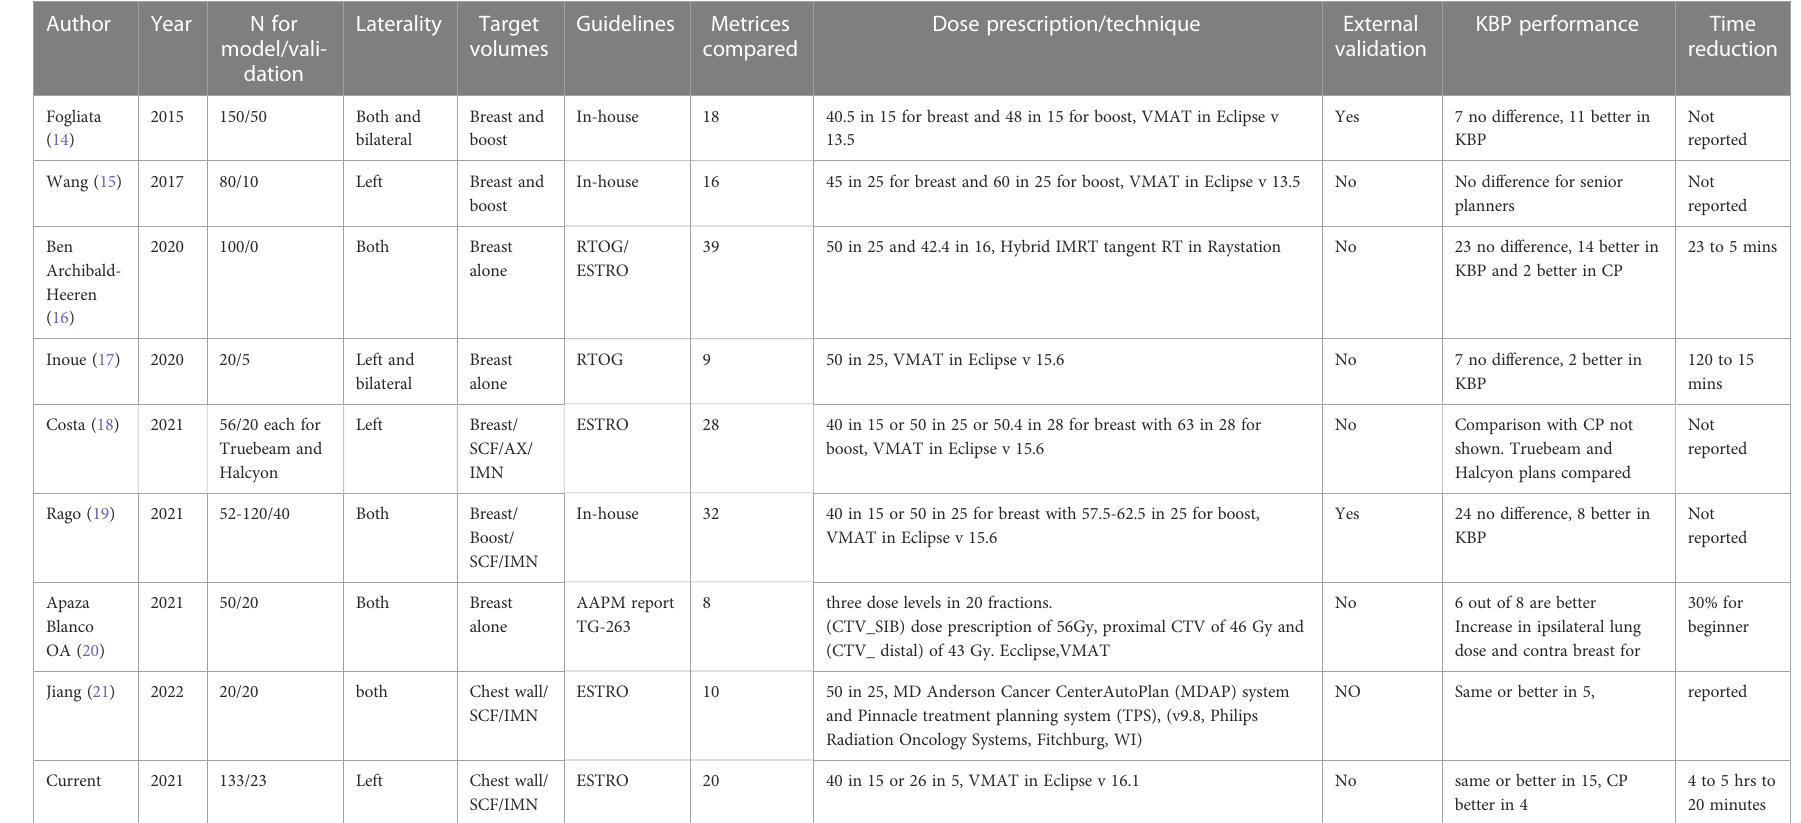
TABLE 3 Review of studies published on rapid planning for breast